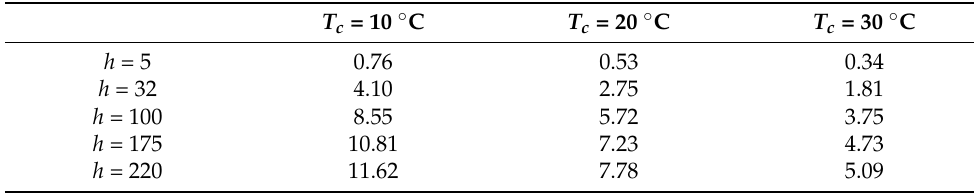
Table 10. Maximum local volumetric current density difference at the negative electrode ( ∆ j f,n,max_diff ) in the discharge process (10 4 A/m 3